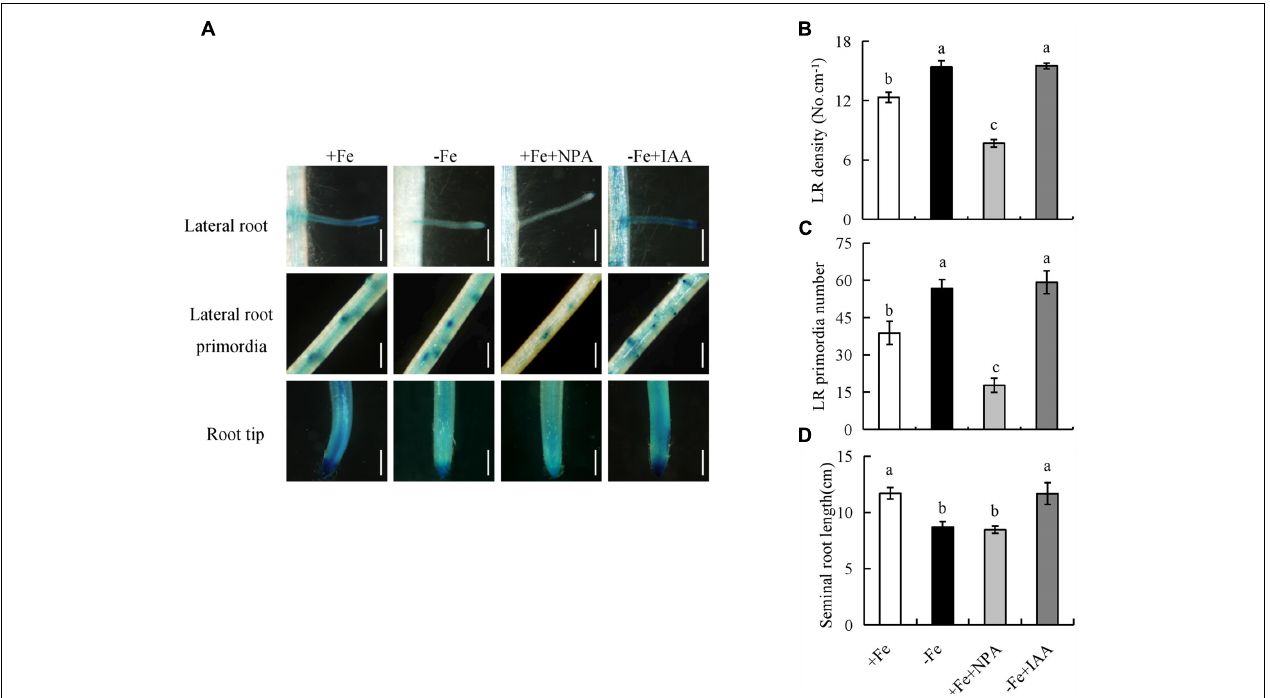
FIGURE 3 | Histochemical localization of DR5::GUS activity and root morphology of seminal root in rice seedlings. Rice seedlings were grown in hydroponic media containing − Fe (0 µ M) and +Fe (20 µ M) in addition to IAA (100 nM) and NPA (100 nM) for 14 days. (A) Plants were stained for GUS activity for 2 h at 37 ◦ C.